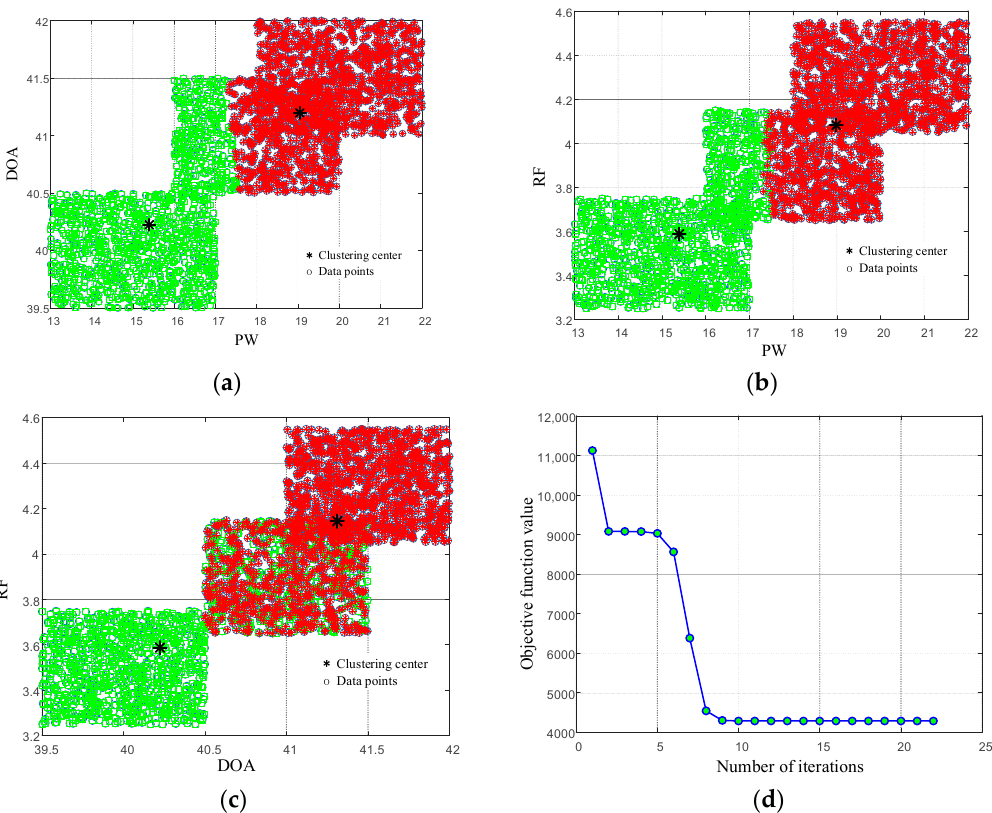
Figure 7. FCM clustering diagrams of signal parameters designed without three-dimensional pseudo-center wide-agile composite modulation. ( a ) PW-DOA two-dimensional cluster diagram. ( b ) PW-RF two-dimensional cluster diagram. ( c ) DOA-RF two-dimensional cluster diagram. ( d ) The change of the objective function.